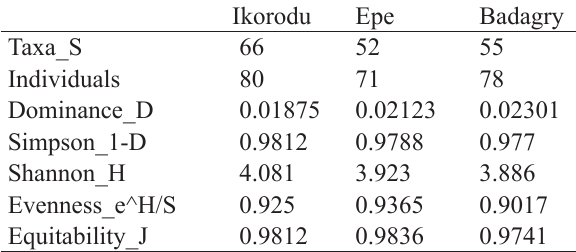
Table 4. Species diversity indices of Ikorodu, Epe and Badagry in Lagos State.